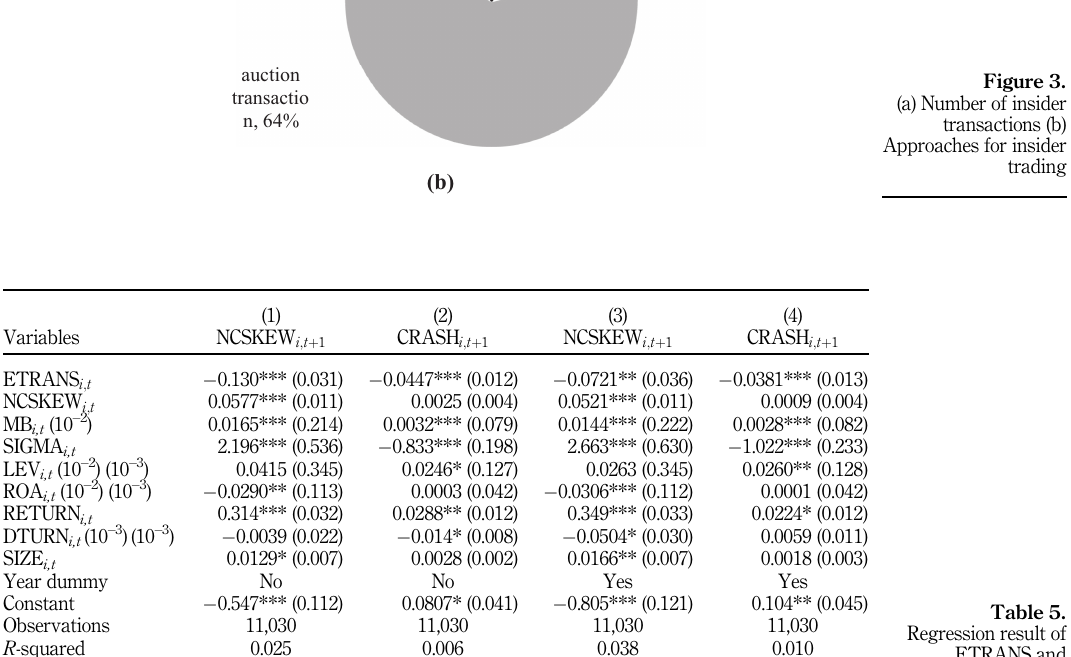
Figure 3. (a) Number of insider